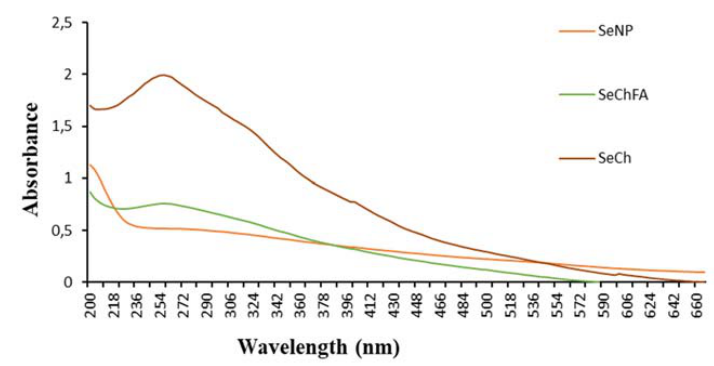
Figure 2. UV-vis spectroscopy of SeNPs before and after Figure 2. UV ‐ vis spectroscopy of SeNPs before and after functionalisation.